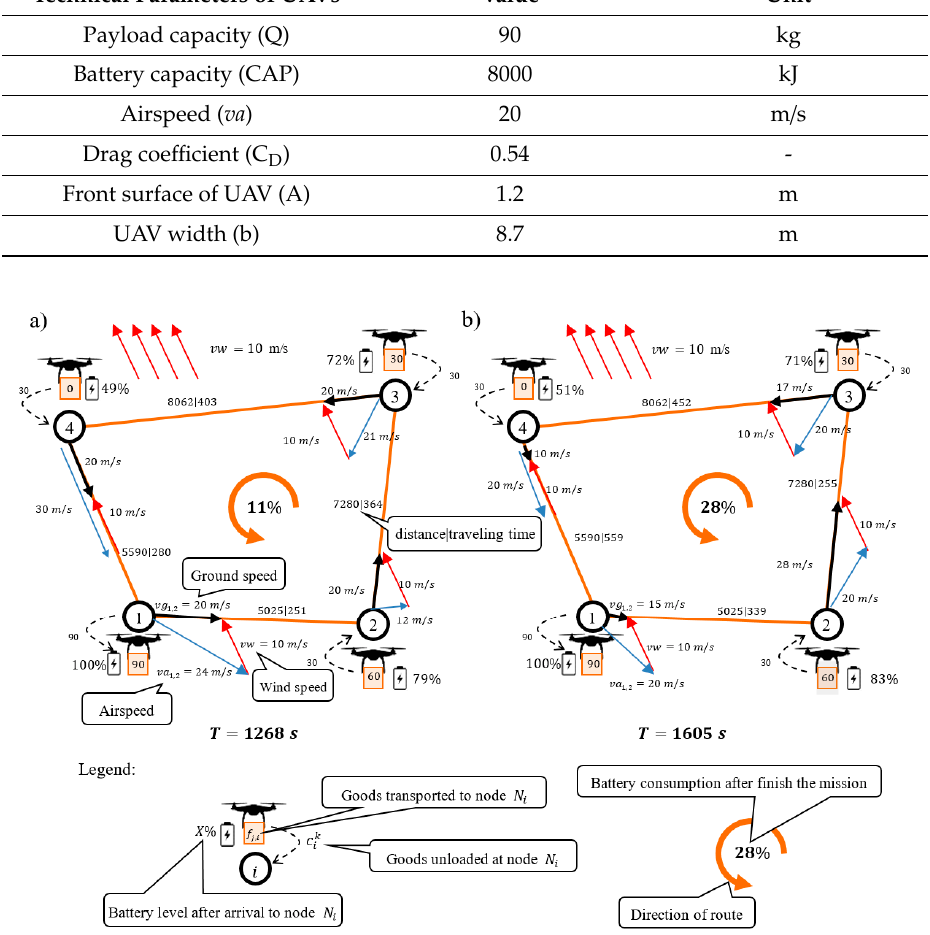
Figure 2. Strategies for delivering goods following a constant ground speed ( a ) and a constant airspeed ( b ).